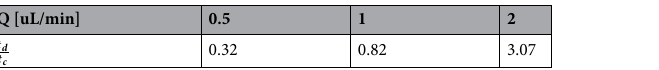
Table 2. Evolution of the ratio t d /t c between the time of diffusion between the capture beads clusters and the residence time inside the fluidized bed due to the flowrate Q of the liquid percolating the bed.